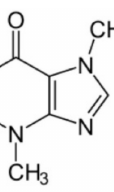
Figure 5. Chemical structure of caffeine. Reprinted with the permission from reference [76]. Copy- right 2017